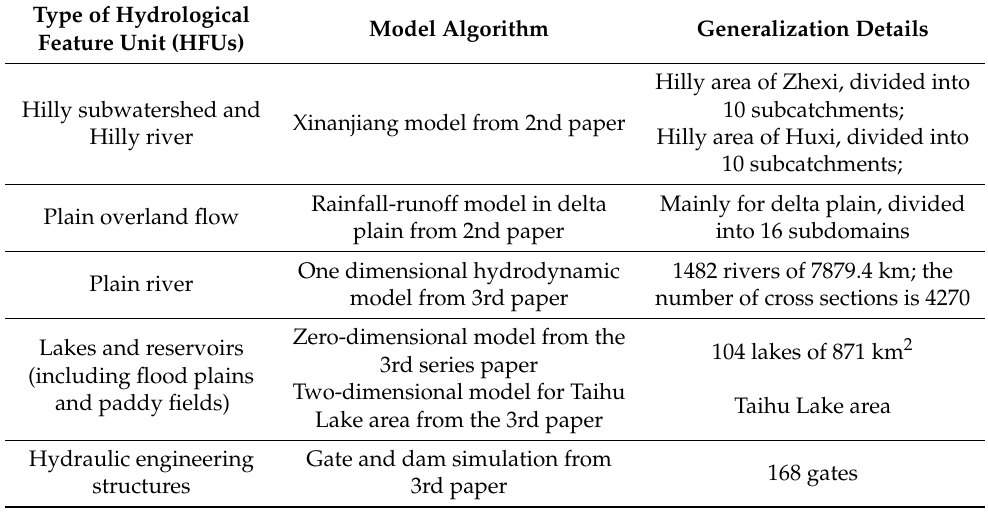
Table 4. Main generalized information for hydrological feature units (HFUs) in Taihu